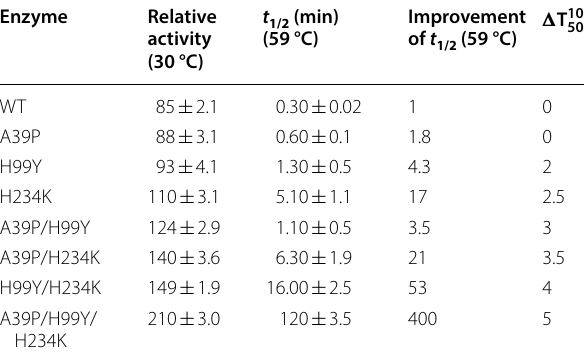
Table 2 Thermostability and activity parameters of wild- type and mutants of AtLBA 4404 UDH